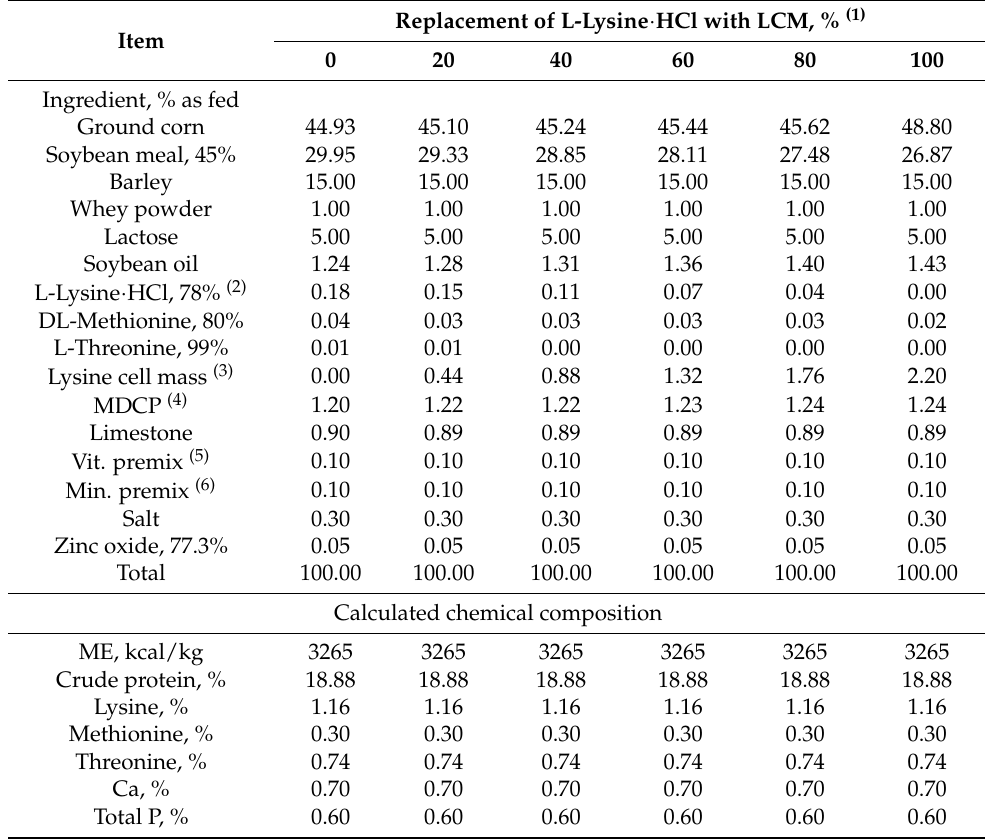
Table 5. The diet formulation and chemical composition of experimental diets for experiment 2 (phase